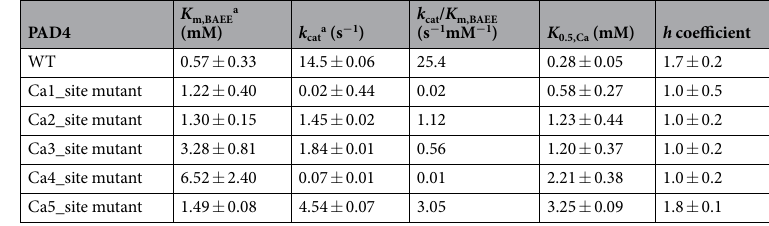
Table 2. Kinetic parameters of PAD4 and the calcium-binding-site mutant